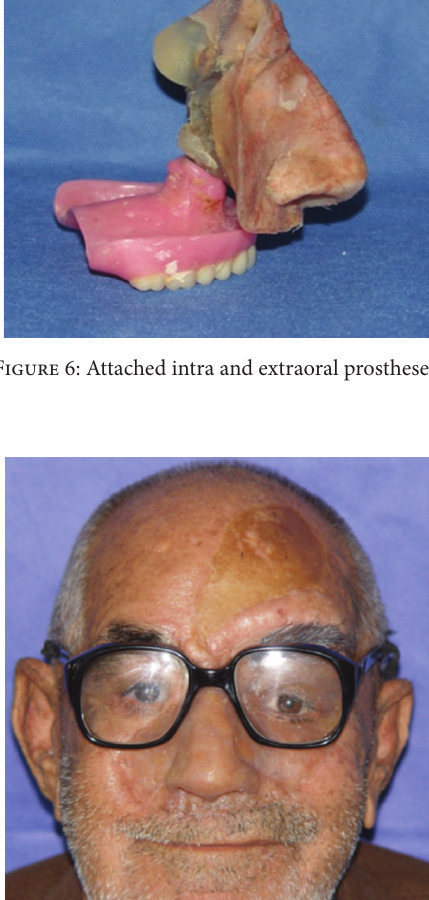
Figure 5: Hollow acrylic substructure.